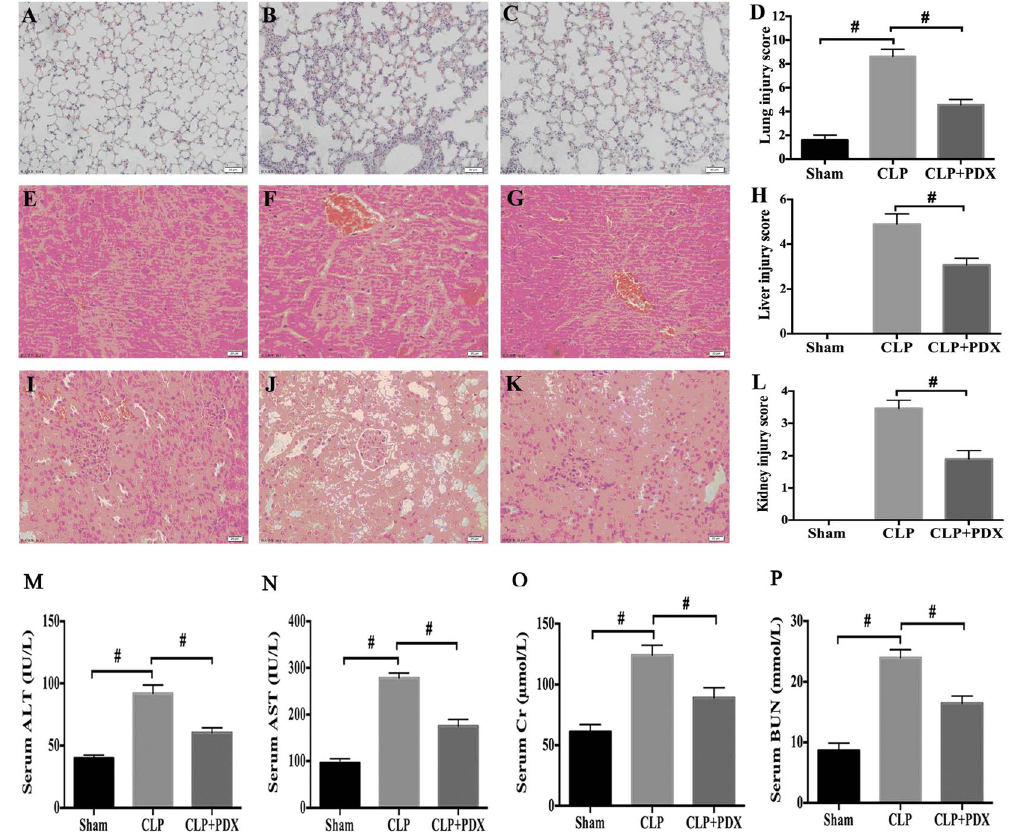
Figure 2. PDX protected CLP mice from multiple-organ injury. Representative images of lung (magnification 200X), liver and kidney (magnification 400X) histology staining with hematoxylin and eosin. The normal lung ( A ), liver ( E ) and kidney ( I ) structure in sham group. CLP mice showed that lung ( B ), liver ( F ) and kidney ( J ) were all injured. PDX mitigated organ injury in septic mice ( C , G and K ). Organ injury scores in the three groups ( D , H and L ). The concentration of alanine aminotranferase (ALT) ( M ), aspartate amniotransferase (AST) ( N ), creatinine (Cr) ( O ) and blood urea nitrogen (BUN) ( P ) in blood was determined by using an automated chemistry analyzer. Data are presented as means ± SEM (n = 6). # P <